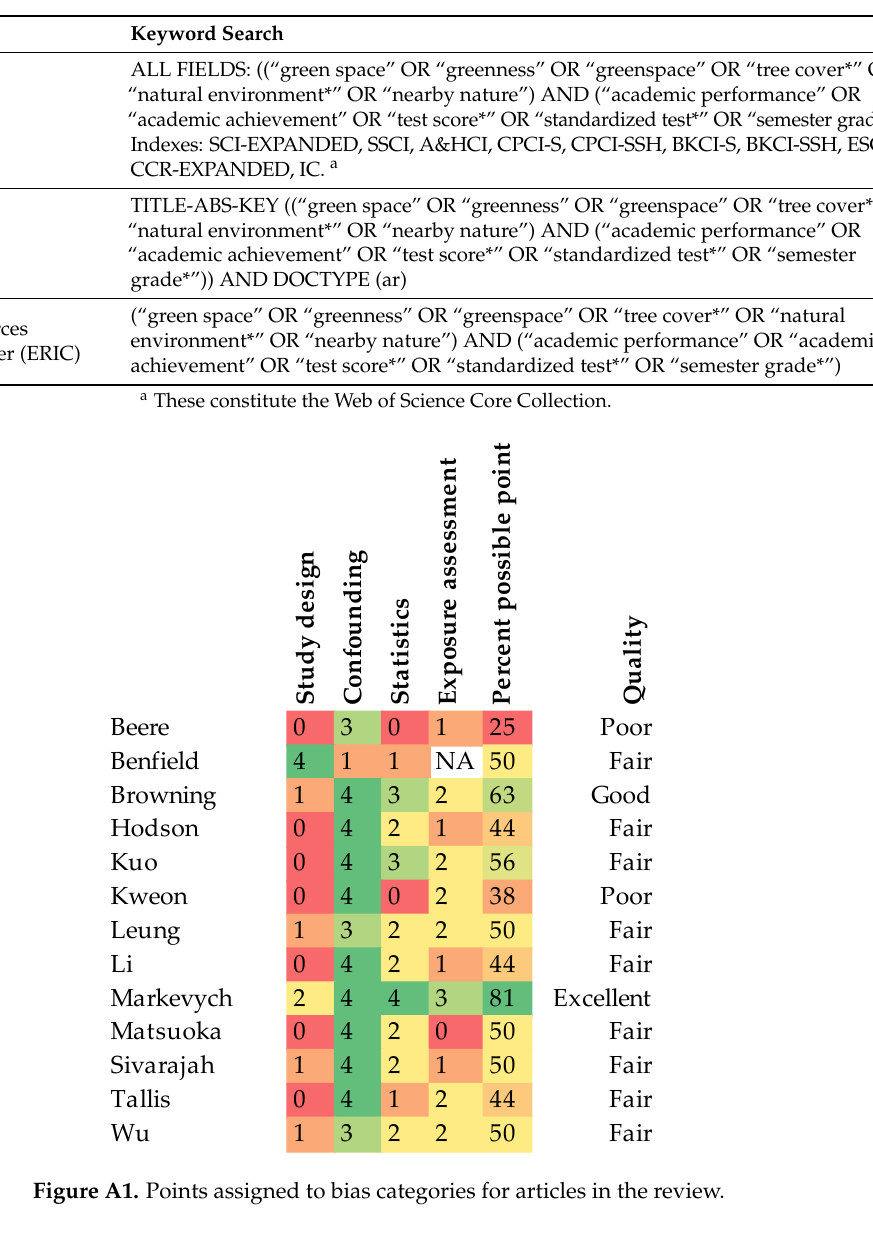
Table A1. Search expressions by database used in the review.